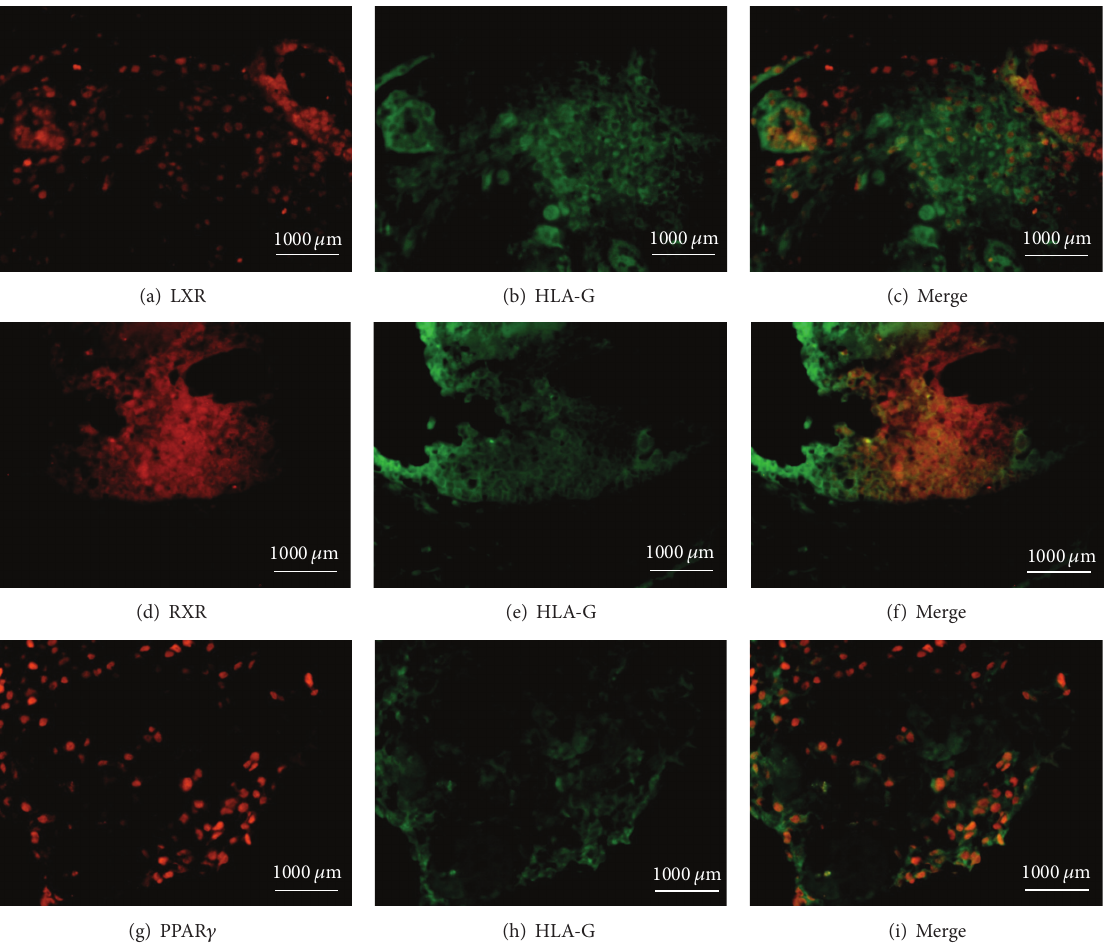
Figure 5: Identification of cells in the abortive decidua expressing nuclear receptors. Expression of LXR (a), RXR 𝛼 (d), and, PPAR 𝛾 (g) is shown in red. Expression of HLA-G as a marker for extravillous trophoblast cells is shown in green ((b), (e), (h), resp.). Coexpression of both, nuclear receptor in red and HLA-G in green, indicates extravillous trophoblast cells expressing LXR (c), RXR 𝛼 (f), and PPAR 𝛾 (i). The same expression scheme was identified in normal control decidua.